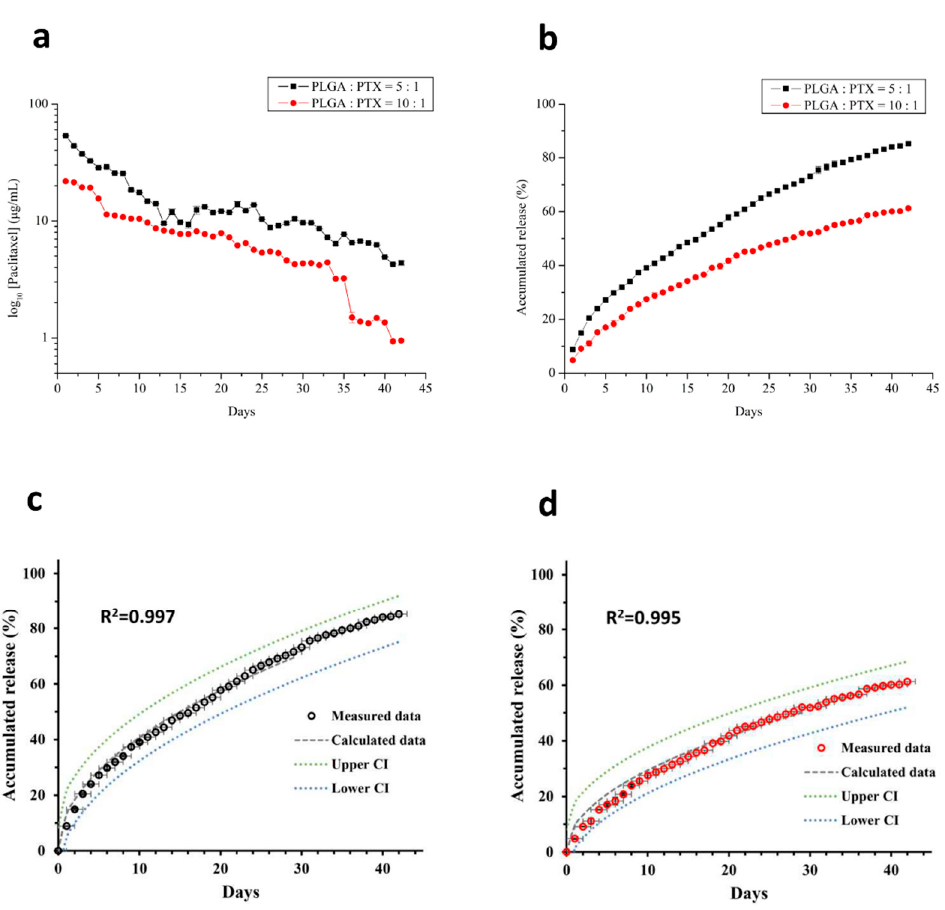
Figure 4. Daily ( a ) and accumulated release ( b ) of PLGA-PTX nanofibers in vitro. The drug release was initially higher in both groups with a gradually decreased release pattern. After 42 days, the accumulated releases of PTX were 85.19 ± 0.4% in the 5:1 polymer-to-drug ratio group and 60.73 ± 1.09% in the 10:1 group. Dissolution profiles and the nonlinear, Higuchi-kinetic-model-calculated release curves of 5:1 ( c ) and 10:1 ( d ) PLGA/PTX ratio nanofibers, with a good fitness indicated by the value of R 2 . All data points are plotted as mean ± SD ( n = 3). CI—confidence interval.